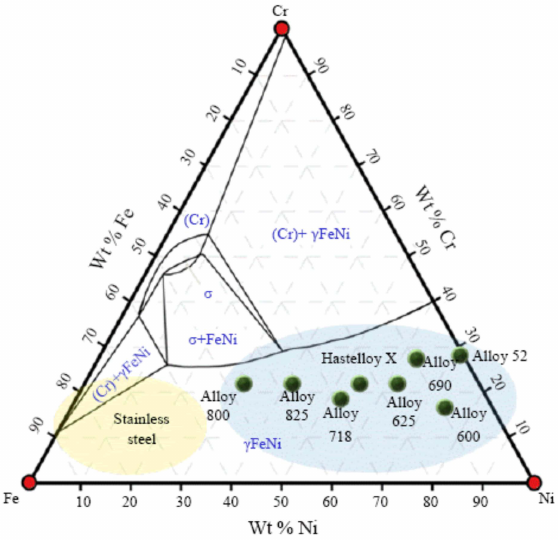
Figure 1. Fe-Ni-Cr ternary phase diagram [13] (Caption: wt %—element weight